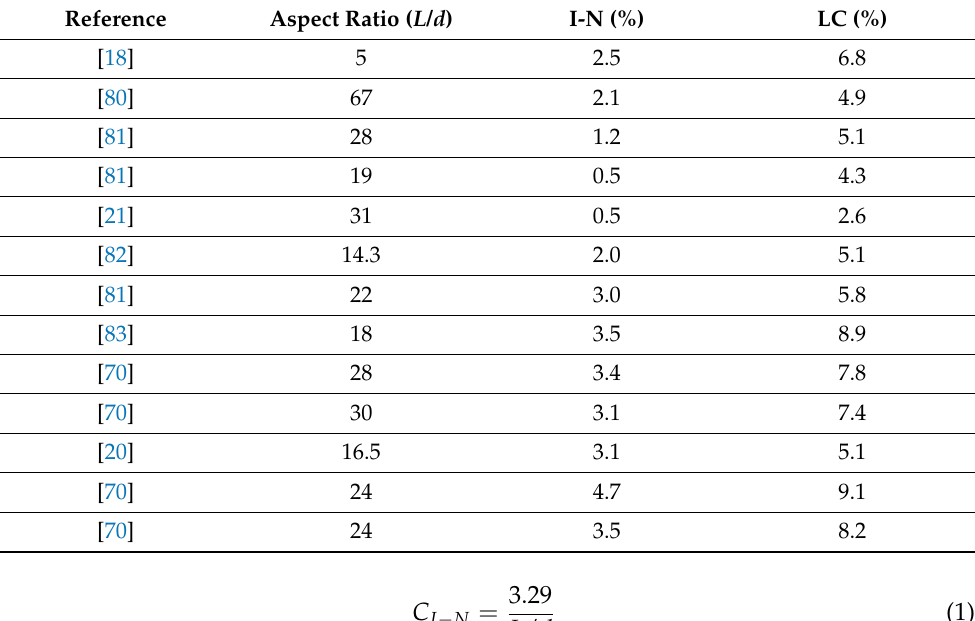
Table 2. Derived from the literature resources, a correlation between the volume fraction of the phase transition point and the volume fraction of the completely crystalline point was found with surfaces sulphate groups (0.89–1 wt%) and polydispersity (PDI) (standard deviation(std) around 30–50% of the average